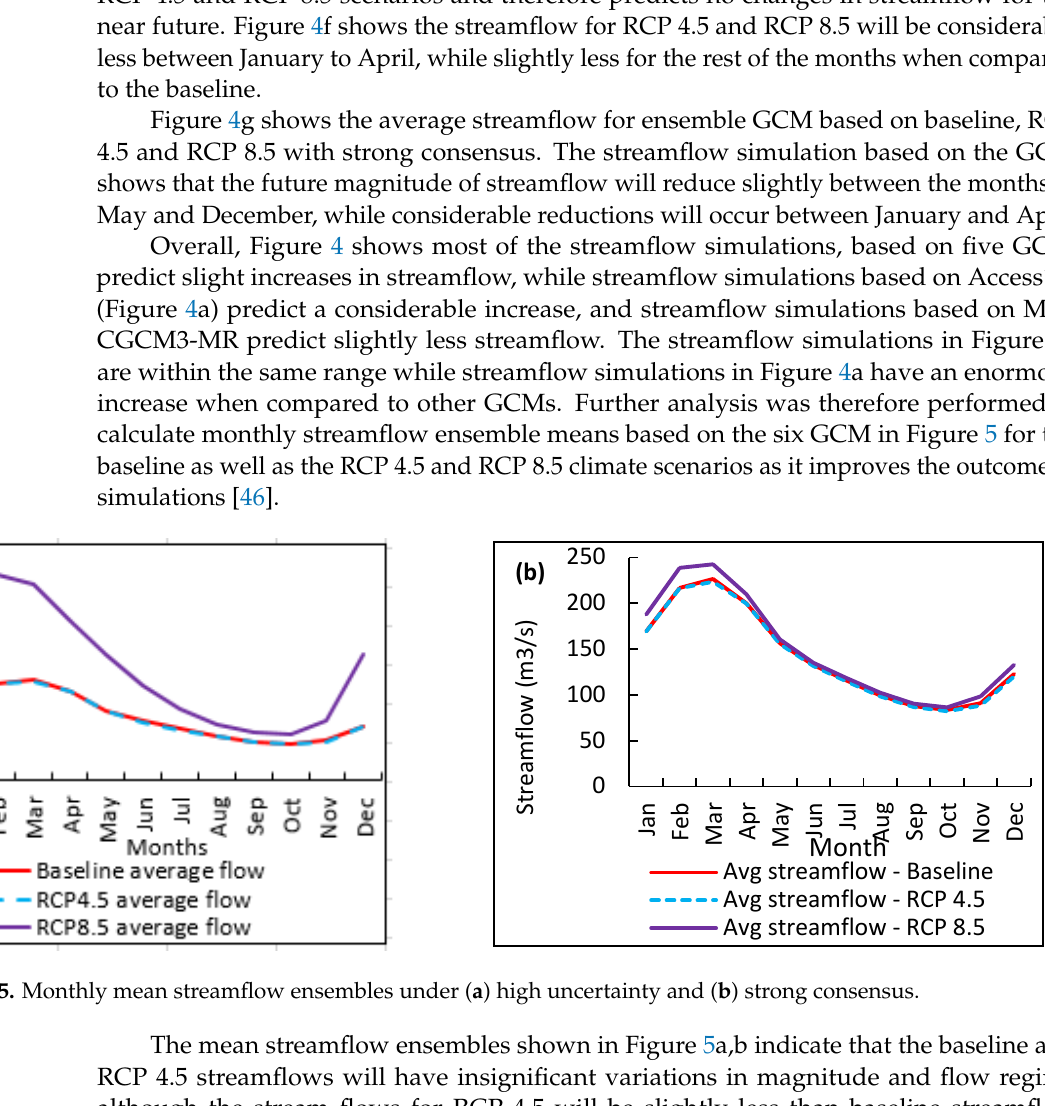
Figure 6. Ensemble mean streamflow changes ( a ) under high uncertainty; and ( b ) strong consensus. Figure 6a shows the highest streamflow of 270 m 3 /s for RCP 8.5, which is much higher than the ensemble means of that of RCP 4.5. The highest increase in streamflow occurs in January, while the lowest increase occurs in September and October. Prediction of the flow regime shows that peak flow occurs in January and recedes gently until September before beginning to rise again in November. Figure 6b shows the highest increase in streamflow of 25 m 3 /s for RCP 8.5 to be moderately higher than the streamflow for RCP 4.5. 3.5. Seasonal Flow Analysis The KRB experiences four seasons, namely December, January and February (DJF) representing the typical rainy season (spring); March, April and May (MAM) indicating